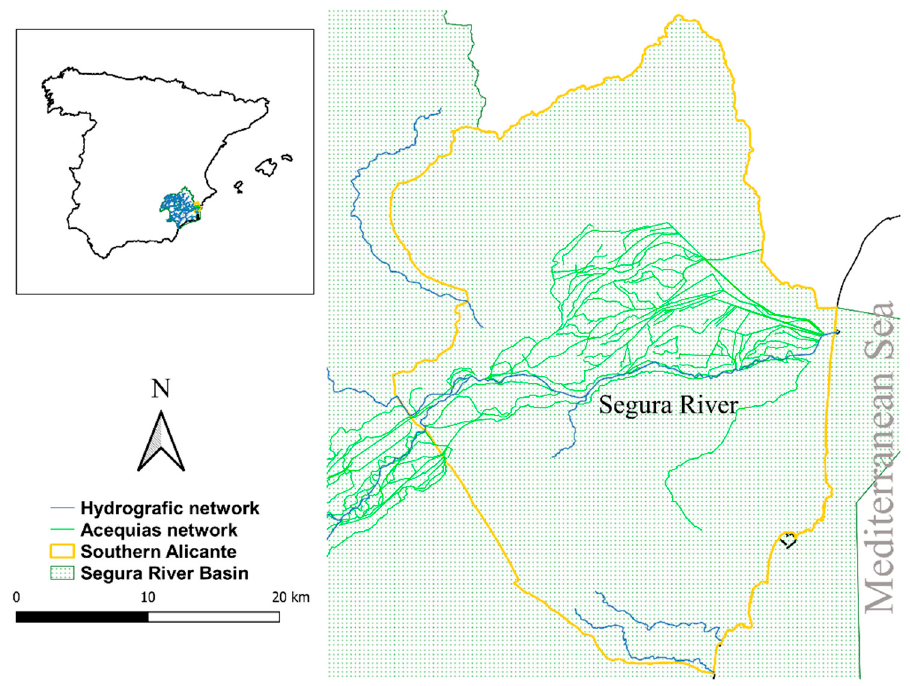
Figure 1. Location of the study area and delineation of the irrigation infrastructure of the Low Segura River Basin at the southern Alicante province.